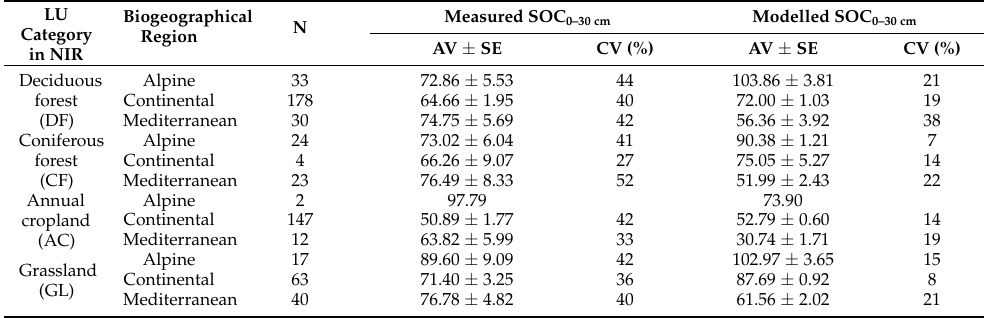
Table 3. Variability in measured and modelled soil organic carbon down to 30 cm regarding different land-use categories and biogeographical regions (average ± standard